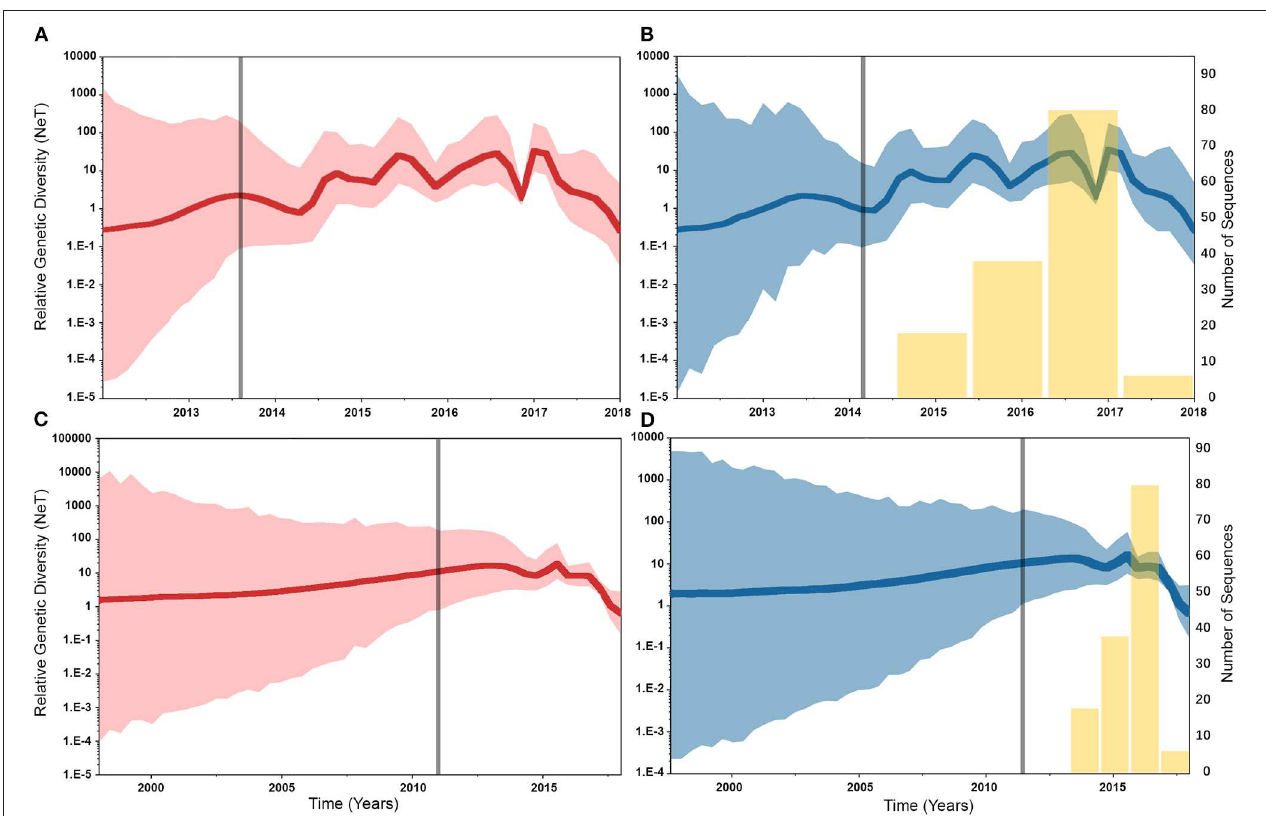
FIGURE 4 | Bayesian Skygrid (SG) plots of the relative genetic diversity through time of hemagglutinin (HA) and polymerase basic 2 (PB2) segments of human-like H3 swine influenza virus collected between January 2015 and June 2018 in the United States. The dark line indicates the posterior median estimate, and the 95% high posterior density (HPD) is indicated by the light shaded areas (red and blue for the asymmetric and symmetric BSSVS priors, respectively). The vertical gray line indicates the estimated time at which the relative genetic diversity transitioned from a slow to a fast growth rate. Yellow bars indicate the temporal distribution of the sequence data. (A) SG plot of HA gene inferred from the asymmetric BSSVS prior. (B) SG plot of HA gene inferred from the symmetric BSSVS prior. (C) SG plot of PB2 gene inferred from the asymmetric BSSVS prior; (D) SG plot of PB2 gene inferred from the symmetric BSSVS